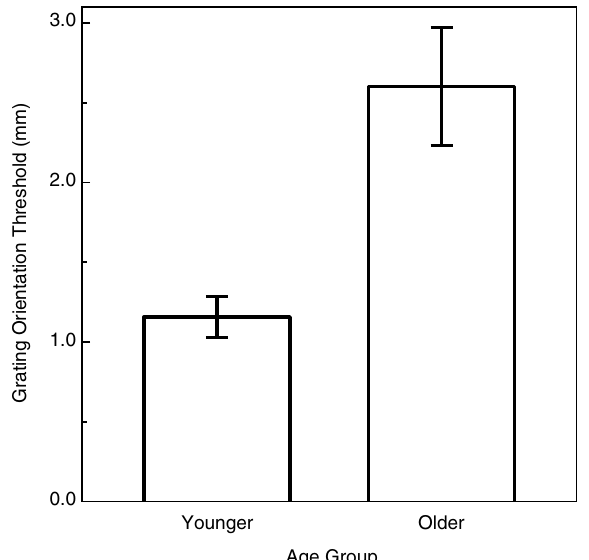
Figure 3. Plots of the younger and older participants’ tactile acuities (i.e., grating orientation thresholds). The error bars indicate ± 1